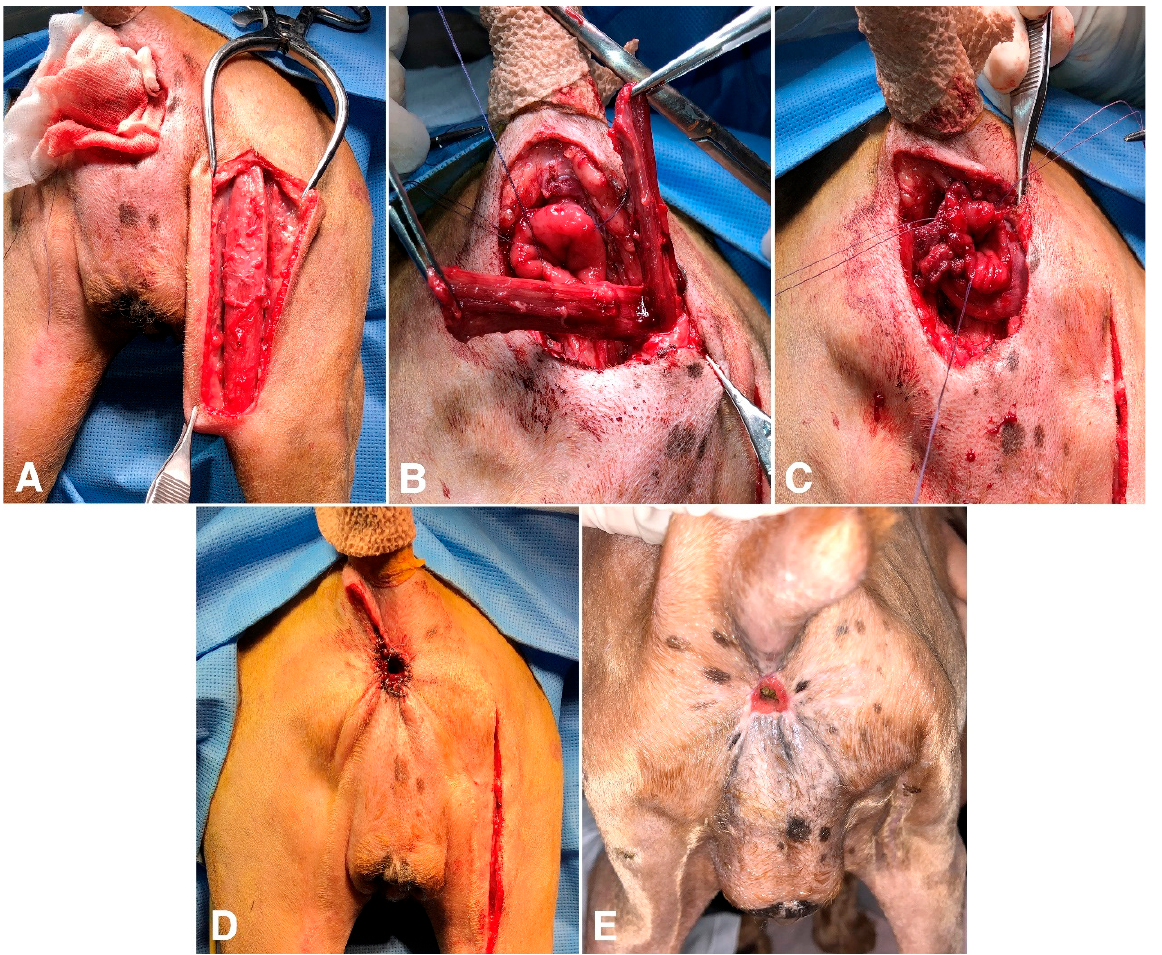
Figure 4. Intraoperative ( A – D ) and postoperative ( E ) views of anorectal resection with a bifurcated semitendinosus muscle flap in a dog with an anal tumor. ( A ) After the anal mass was resected en bloc with clear margins, the semitendinosus muscle was carefully dissected from the surrounding tissue. ( B ) The semitendinosus flap was transposed to the anal region through the subcutaneous tunnel, and the distal end of the flap was bifurcated into two bundles. ( C ) The two bundles were wrapped around the anus and suture the ends of the bundles with each other to narrow the intestinal lumen. ( D ) Intestinal transected edges were sutured to the skin, leaving a small passage for feces. ( E ) At the postoperative three-month follow-up, the reconstructed anus maintained its narrowed orifice diameter (5 mm), and the dog showed a normal defecation pattern.